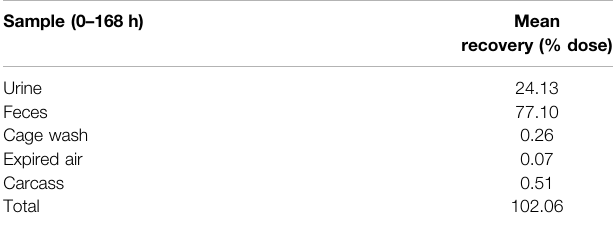
TABLE 2 | Pharmacokinetic parameters following a single oral administration of [ 14 C]DF2755AtofemaleSDratsatatargetdoseof20 mgfree-compound/kg. Parameter Radioactivity in plasma